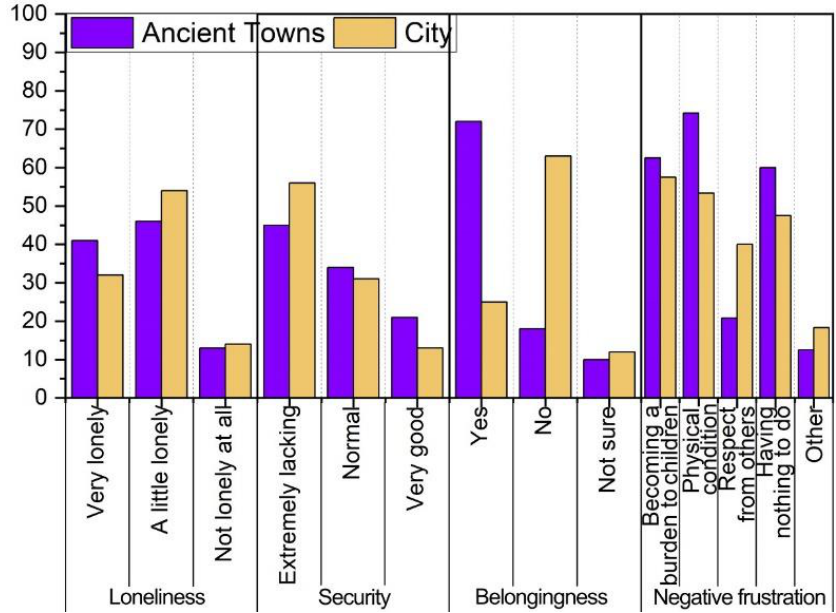
Figure 8. Psychological characteristics of the elderly in ancient towns.